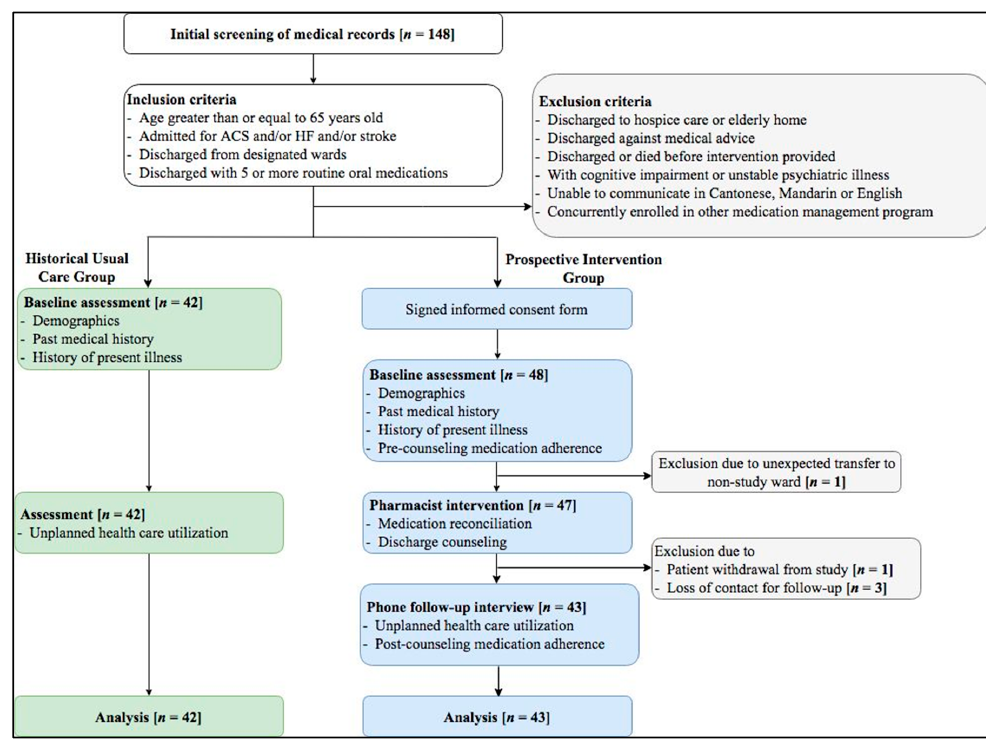
Figure 1. Study schema. ACS = acute coronary syndrome; HF = heart failure.